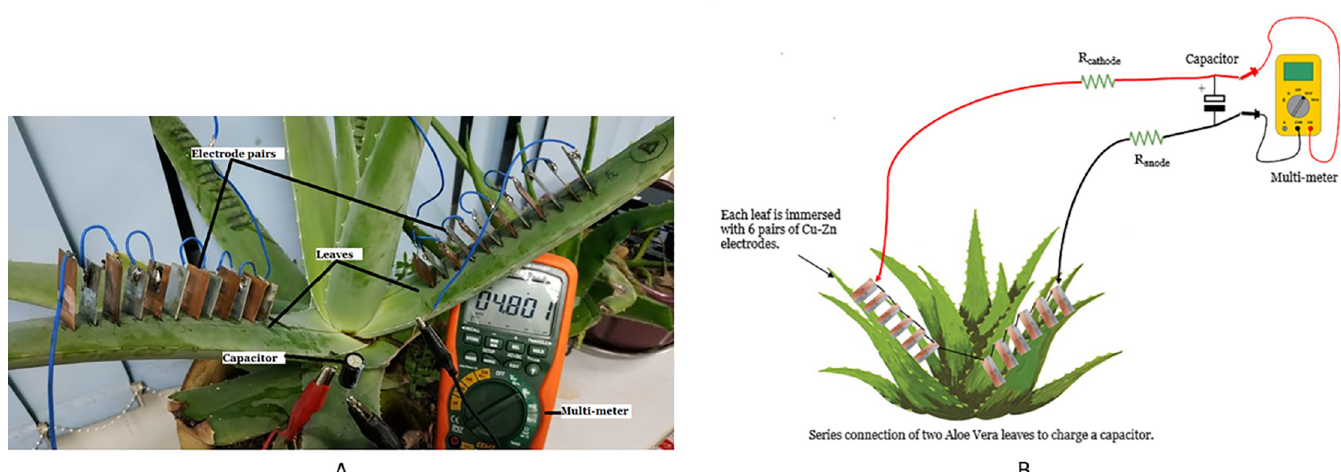
Fig 13. Experiment setup for charging a capacitor using the PBC system. Example of setup arrangement (A) and simple schematic of the setup (B).